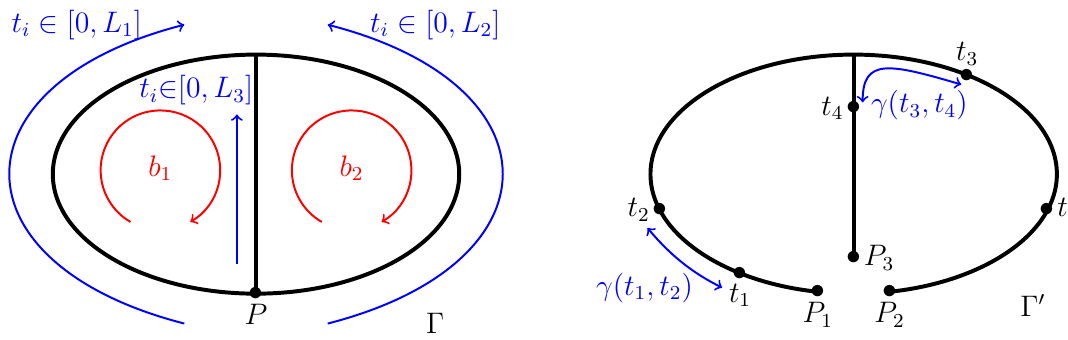
Figure 5 . The left panel exhibits the two-loop 1PI skeleton graph (cid:0) with a choice of homology basis and parametrization. The right panel exhibits the simply connected graph (cid:0) 0 = (cid:0) n P obtained by removing one vertex P from (cid:0), and labeling P a the endpoint of the edge e a . On (cid:0) 0 each pair of points t i ; t j is connected by a unique path (cid:13) ( t i ; t j ). When t i ; t j are on the same edge we have @ i L ( t i ; t j ) = sgn( t i (cid:0) t j ) dt i , while when t i ; t j are on di(cid:11)erent edges we have @ i L ( t i ; t j ) = (cid:0) dt i . For the purpose of illustration, we have displayed vertices corresponding to (a permutation of) graph ( c ) in (cid:12)gure 1, the other graphs being